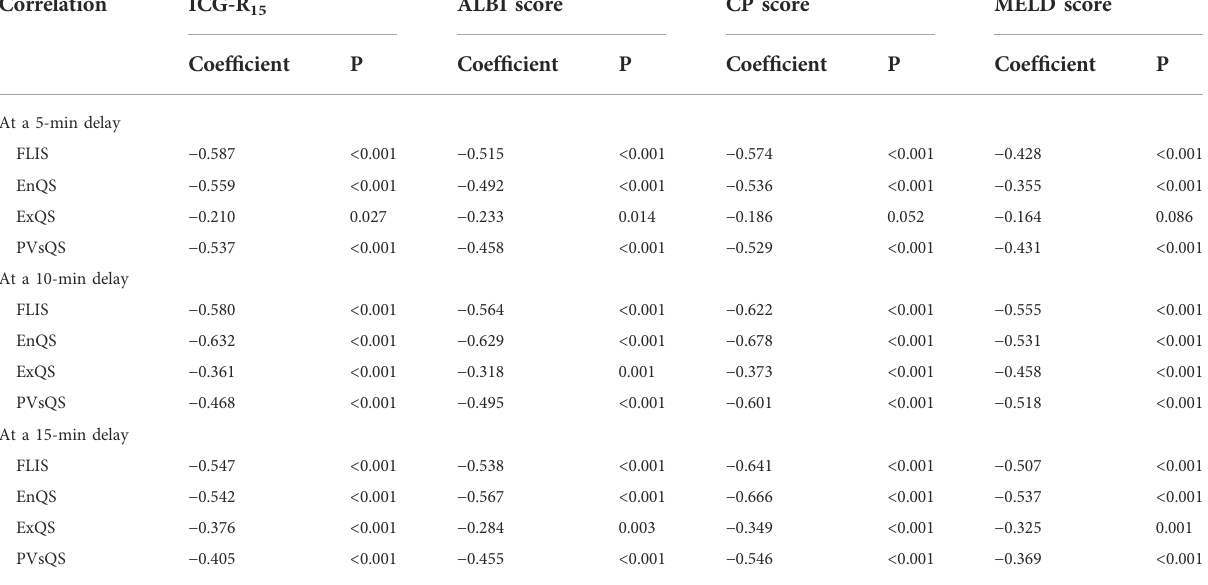
TABLE 5 Correlations to ICG-R 15 , ALBI score, CP score and MELD score for FLIS and three FLIS parameters at different time points.